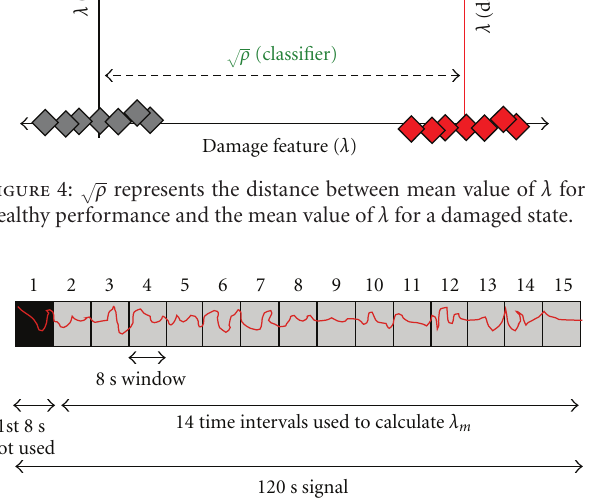
Figure 5: Schematic representation of the acceleration signals and the 15 windows in the signals.